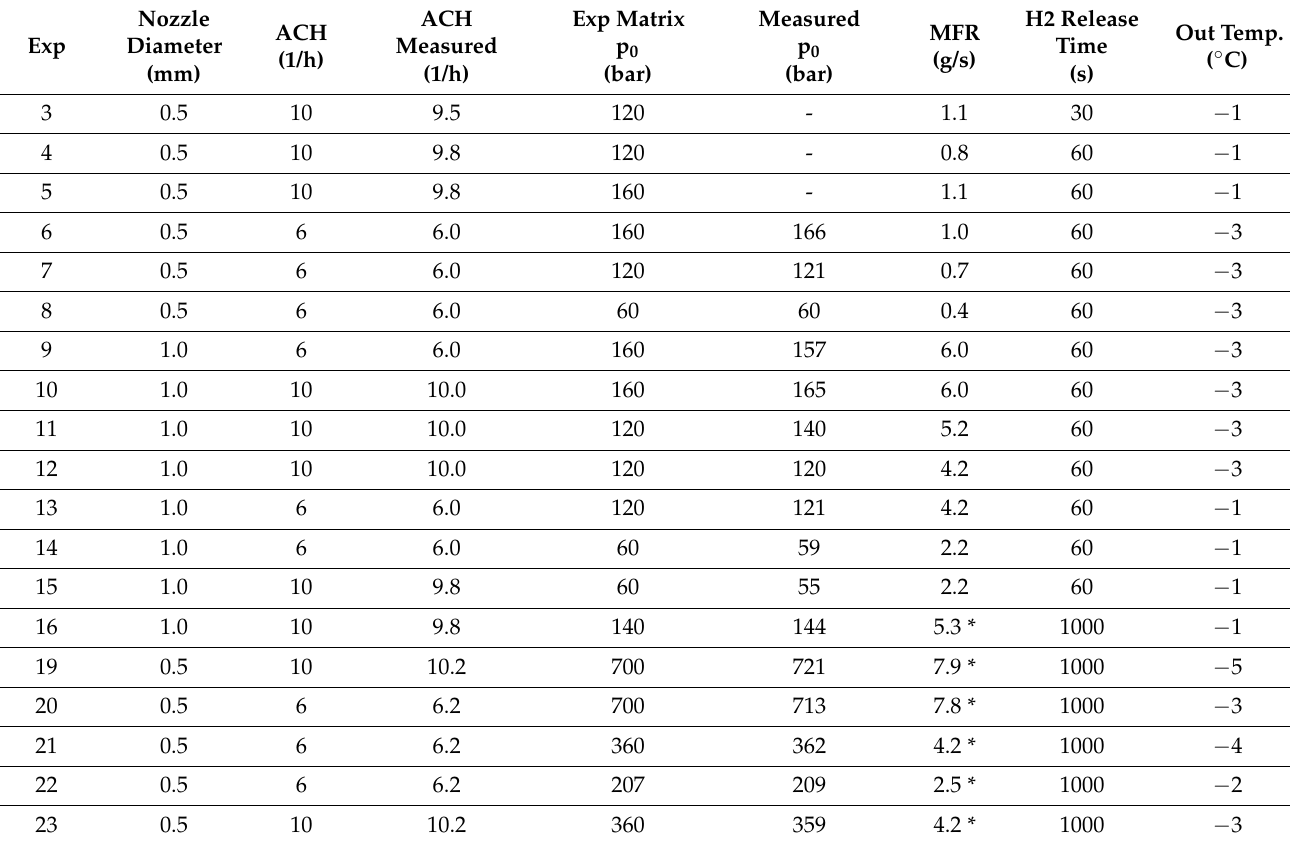
Table 2. Experimental